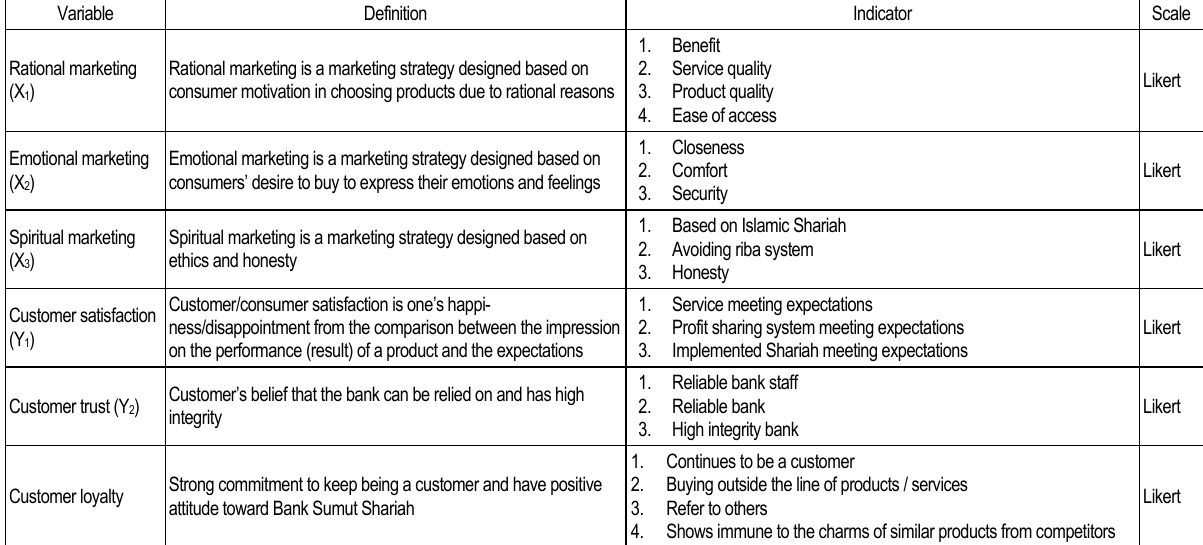
Table 1. Variable